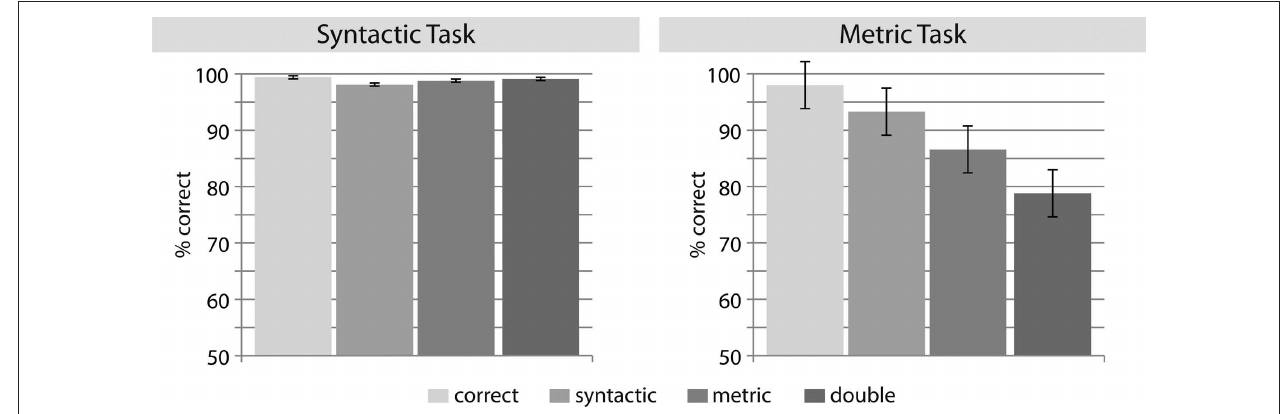
Figure 3 | Percentage of correctly answered trials for each condition and